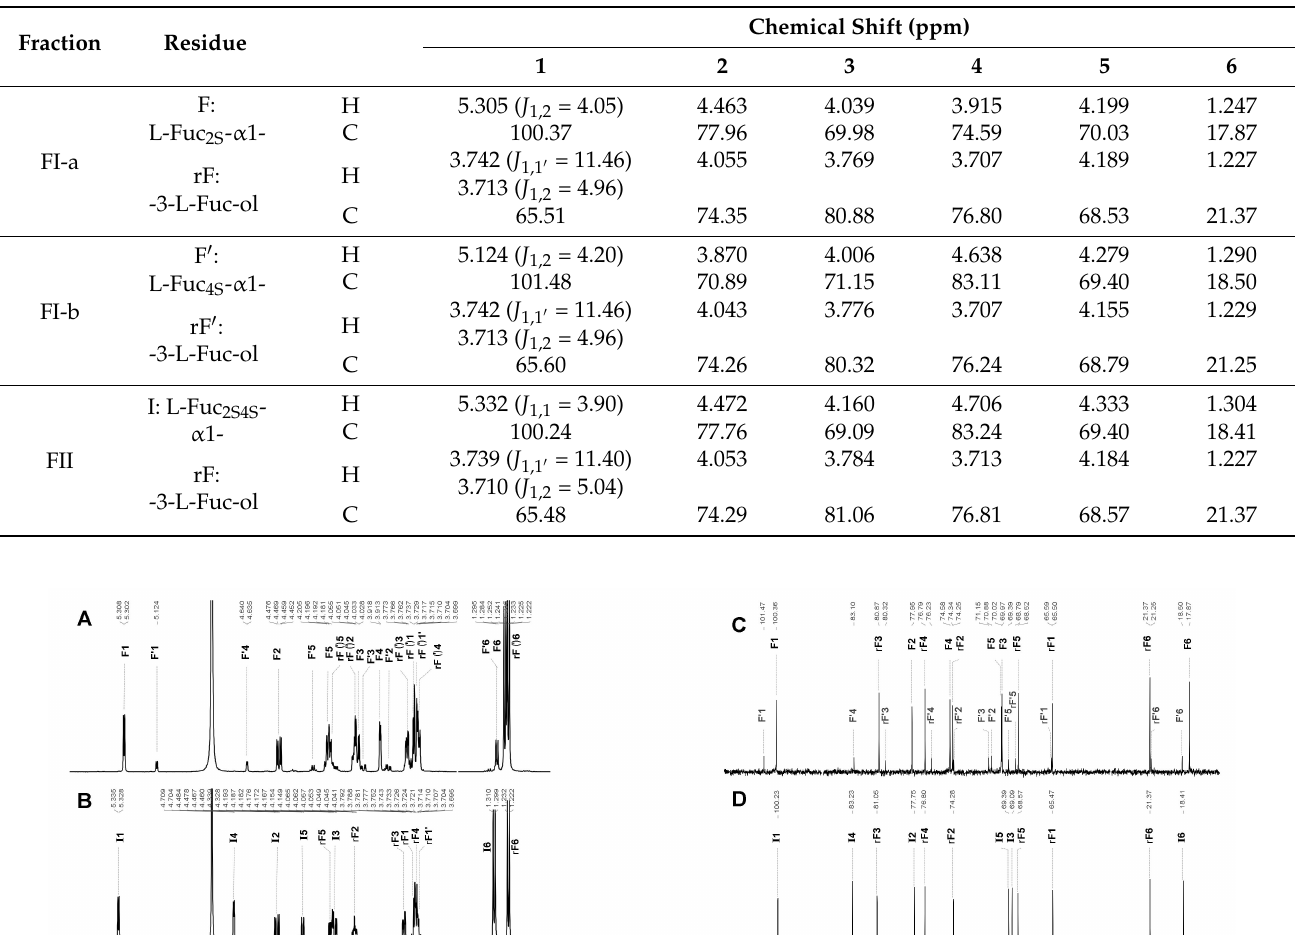
Table 1. 1 H and 13 C chemical shifts of the oligosaccharide FI and FII.